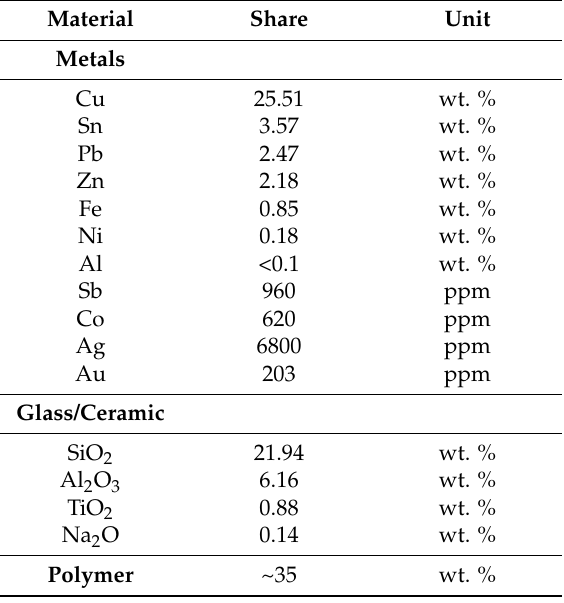
Table 1. Chemical composition of mechanically treated